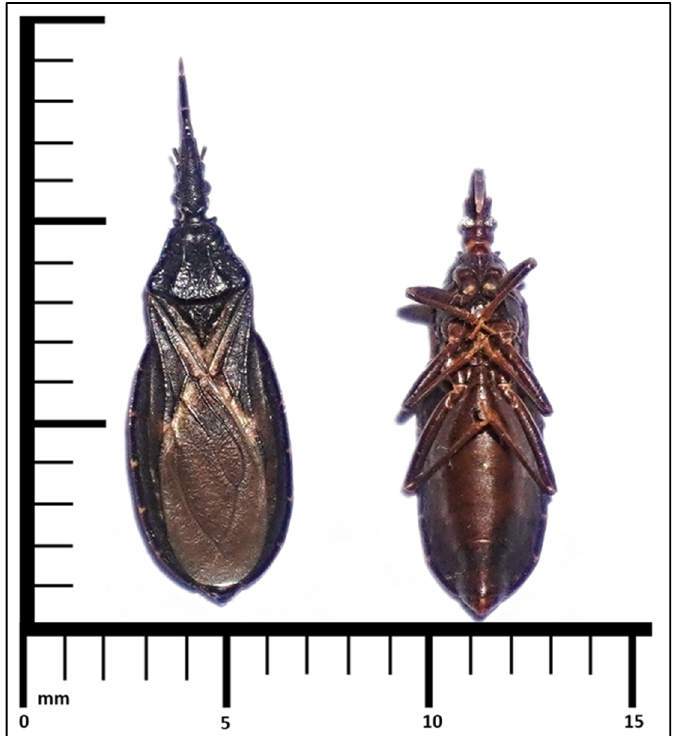
Figure 2. Dorsal ( left ) and ventral ( right ) views of adult female Triatoma protracta (Uhler) collected from home in Mendocino County, California, USA.